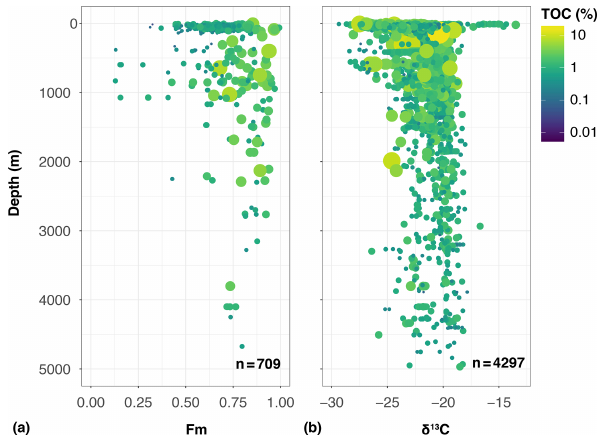
Figure 4. (a) Fraction modern versus depth; bubble size and colour indicate sample TOC content (%). On ocean shelves (shallow depths) we observe generally low TOC values and depleted Fm val- ues. Carbon in deeper oceans shows a larger spread in ages and TOC content. (b) δ 13 C modern versus depth; bubble size and colour in- dicate sample TOC content (%). On ocean shelves (shallow depths) we observe a large spread in ∂ 13 C values. Carbon in deeper oceans shows a smaller spread and converges to less depleted δ 13 C values.